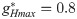
Effective community selection can encourage species coexistence.Here, the evolutionary upper bound for gHmax (gHmax*=0.8) was larger than that for gMmax (gMmax*=0.7), opposite to that in Figs 2–5. (A) When the top-dog strategy and pipetting were used to choose and reproduce Adult communities, M was almost outcompeted by H as H evolved to grow faster than M (rows 3 and 4). Although M would ordinarily go extinct, community selection managed to maintain M at a very low level (bottom). This imbalanced species ratio resulted in very low community function (top). (B-D) When community selection was effective, using top-dog with cell sorting (panel B), top-tier with pipetting (panel C), or top-tier with cell sorting (panel D), community selection successfully improved community function and f¯P. In these cases, H’s growth parameter did not increase to its evolutionary upper bound (panel B-D row 3, also see S17B–S17D Fig), allowing a balanced species ratio (panel B-D bottom) and high community function (panel B-D top). Resource supplied to Newborn communities here supports 105 total biomass to accommodate faster growth rates (and hence community function is larger than in other figures). Black, cyan, and gray curves represent independent simulation trials. P¯(T) (average community function) and ϕ¯M(T) (average fraction of M biomass in Adult communities) were averaged across the chosen Adults. f¯P(T) was obtained by first averaging among M within each chosen Adult and then averaging across all chosen Adults. The simulation codes can be found in S4 Code, and the data can be found in S3 Data. Adult, Adult community; H, Helper; M, Manufacturer.